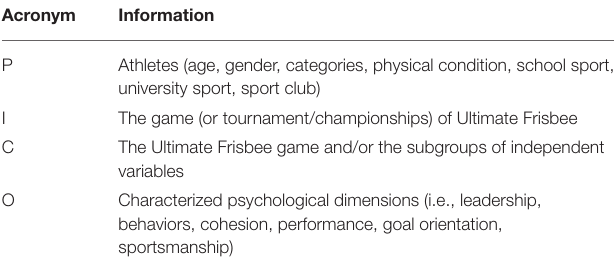
TABLE 2 | Presentation of the characteristics of the studies included in the review according to of adapted PICOS